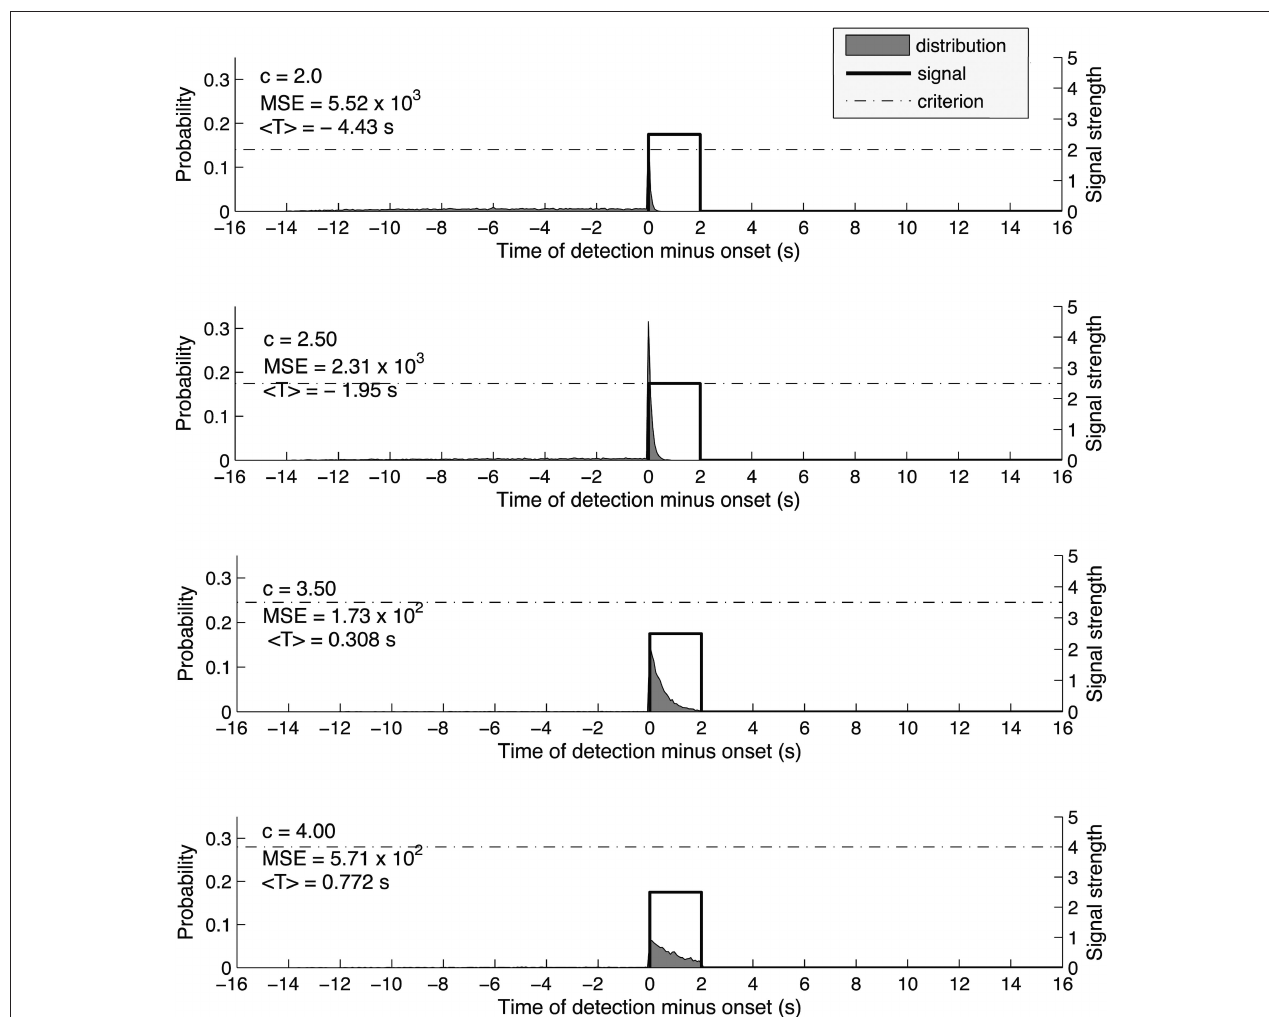
Figure 1 | We set the duration of the trial epoch to 16 s and broke the time interval into 200 time bins, in accordance with a signal sampling rate of 12.5 Hz. The signal was a step function and had duration of 2 s, constant signal strength of 2.5 times the SD of the noise which was modeled to have a Gaussian distribution with a mean of 0 and SD of 1. We computed the distribution of detection times for each of 21 values of the criterion, from c = 0 to c = 5 (only 4 of them are shown in this figure). Detection times vary from 14 s prior to the onset of the signal to 16 s after